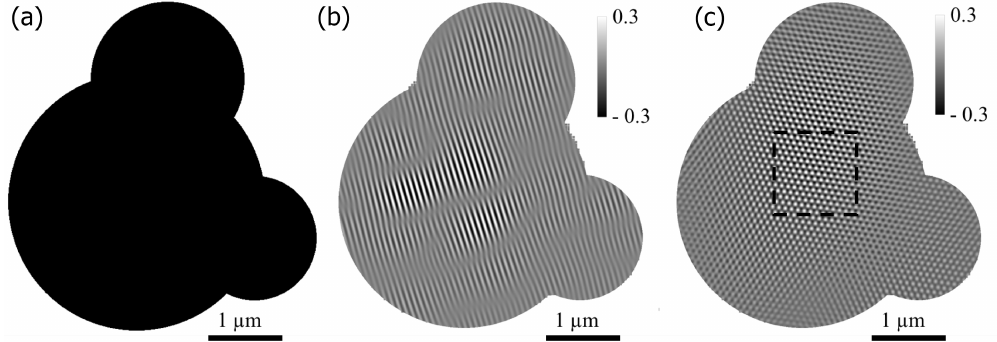
Figure 4. ( a ) Real-space support used for iterative phase retrieval; ( b ) Imaginary part of the reconstruction of the magnetic texture of FeGe at B = 0 mT (helical phase) and ( c ) B = 50 mT (SkX phase). The grayscale bar is given in arbitrary units. The black rectangle in panel (c) indicates the magnification area shown in Figure